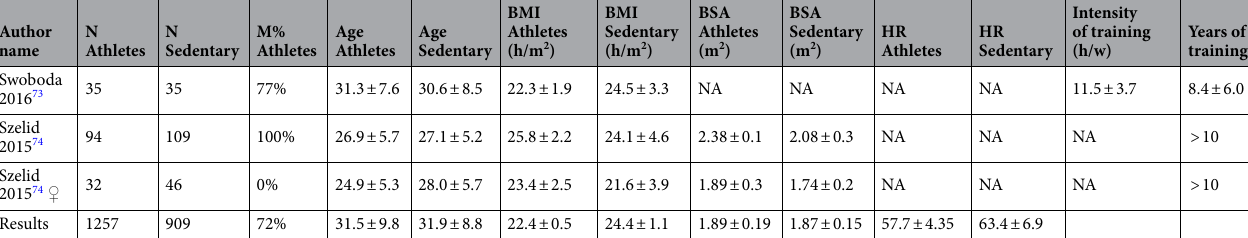
Table 2. Population demographics in CMR studies. ♀ Data on female extracted from article with mixed population (including both sex). °Data on athletes aged < 18 extracted from article with age mixed population. ◄ Different athletes population analysed in the same article with the same sedentary control. NA, not available; M%, percentage of male; h/w, hours/week.